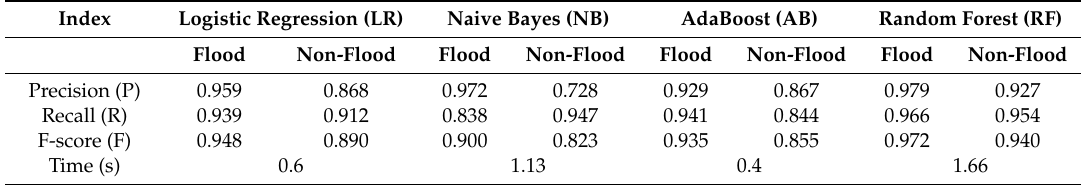
Table 2. Evaluation index of the four models.